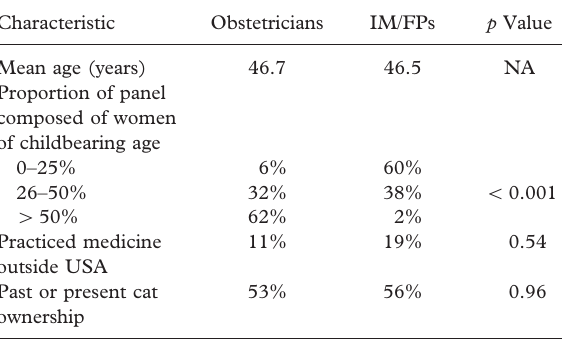
Table I. Baseline demographic characteristics of responders.